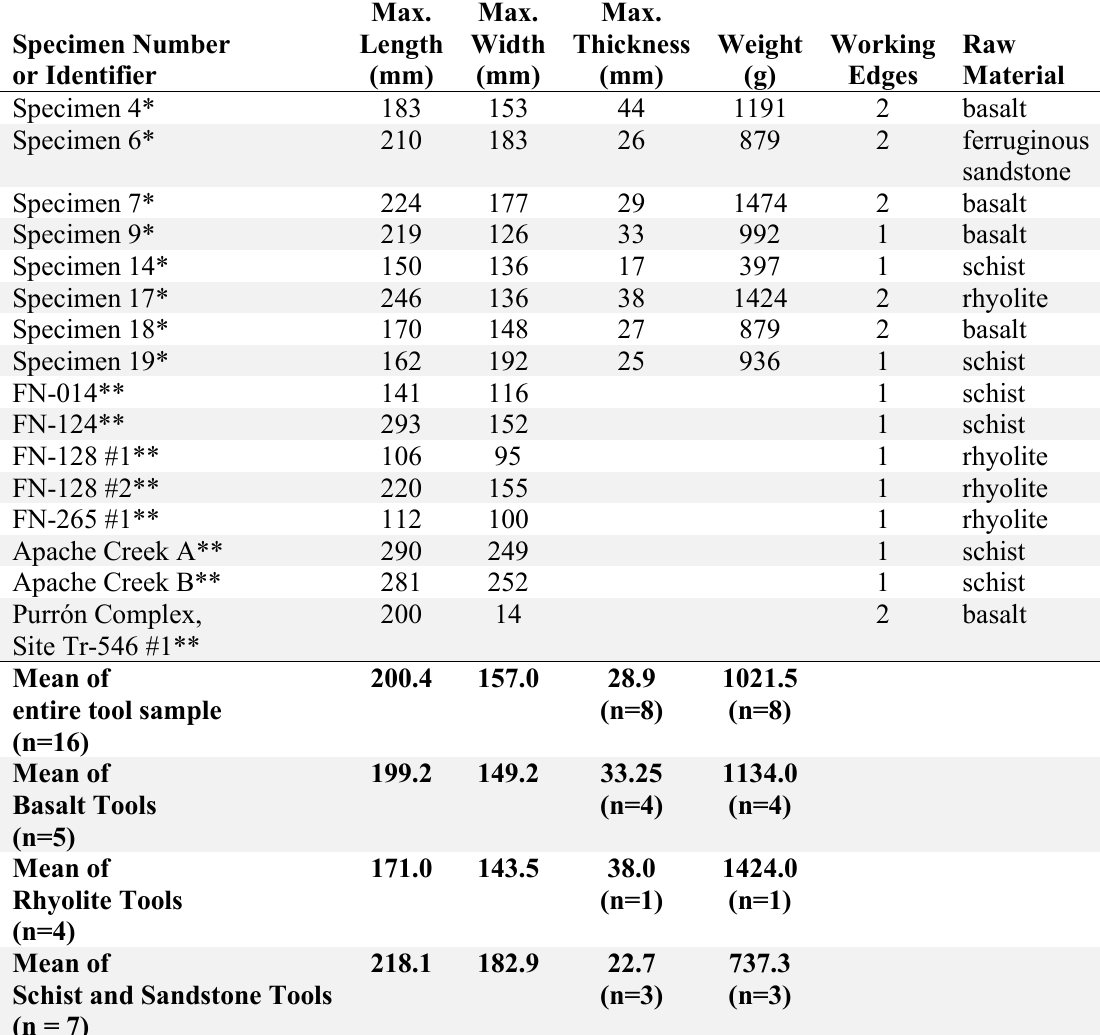
Table 1. Metric Characteristics of Disc, Elliptical, Ovate-shaped tools (n=16). Specimen numbers having one asterisk were subject to detailed metric analyses. Specimen numbers having two asterisks represent tools well documented in the field or gleaned from the